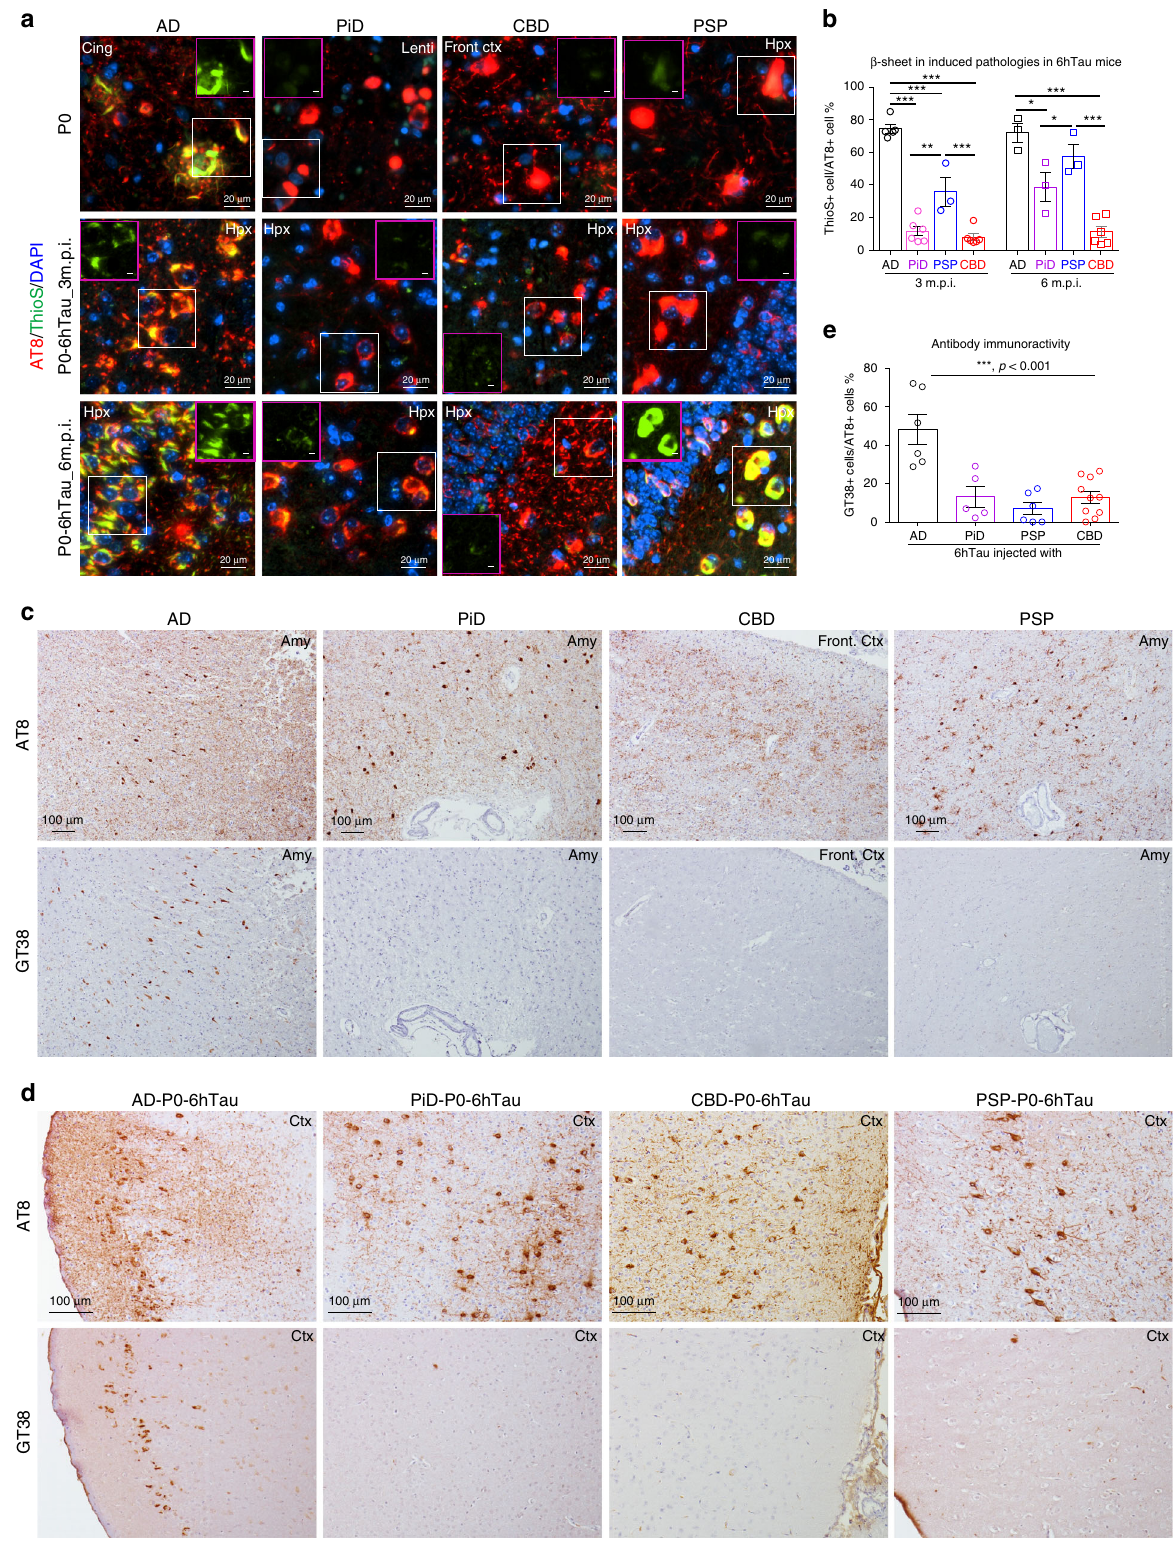
For NFL (neuro fi lament light chain, 1:1000, Rabbit, homemade) and MAP2 (1:2000, AB5543, Millipore) staining, primary hippocampal neurons were fi xed with 4% PFA at room temperature (RT) for 20 min and permeabilized with 0.01% Triton-X for 10min. For insoluble tau, neurons were fi rst extracted with 1% hexadecyltrimethylammonium bromide (Sigma-Aldrich) to remove soluble tau and fi xed with 4% PFA afterward. A mouse tau-speci fi c antibody (R2295M,